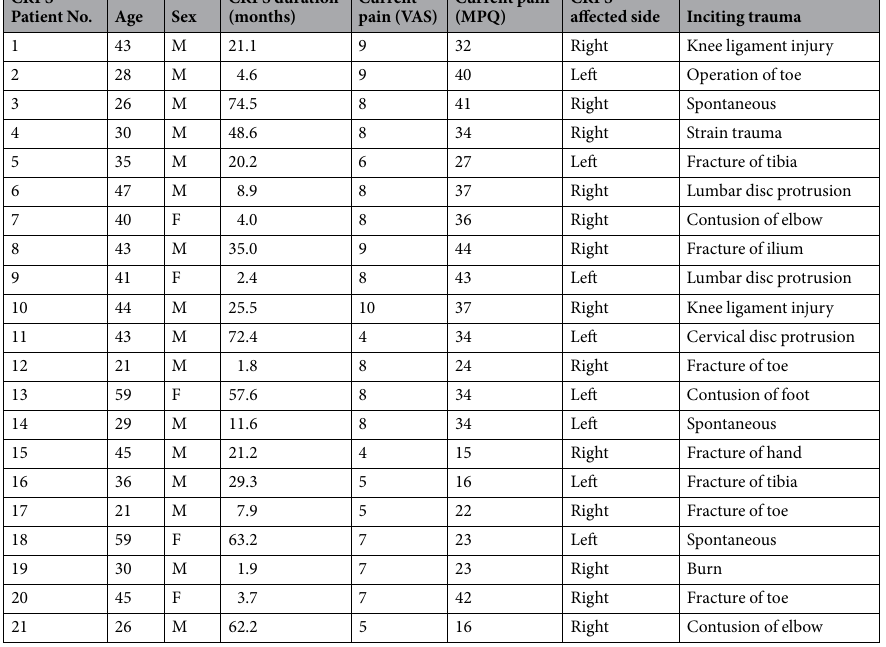
Table 2. Clinical characteristics of participants with CRPS. Abbreviations: CRPS, chronic regional pain syndrome; VAS, visual analog scale; MPQ, the short-form of the McGill pain